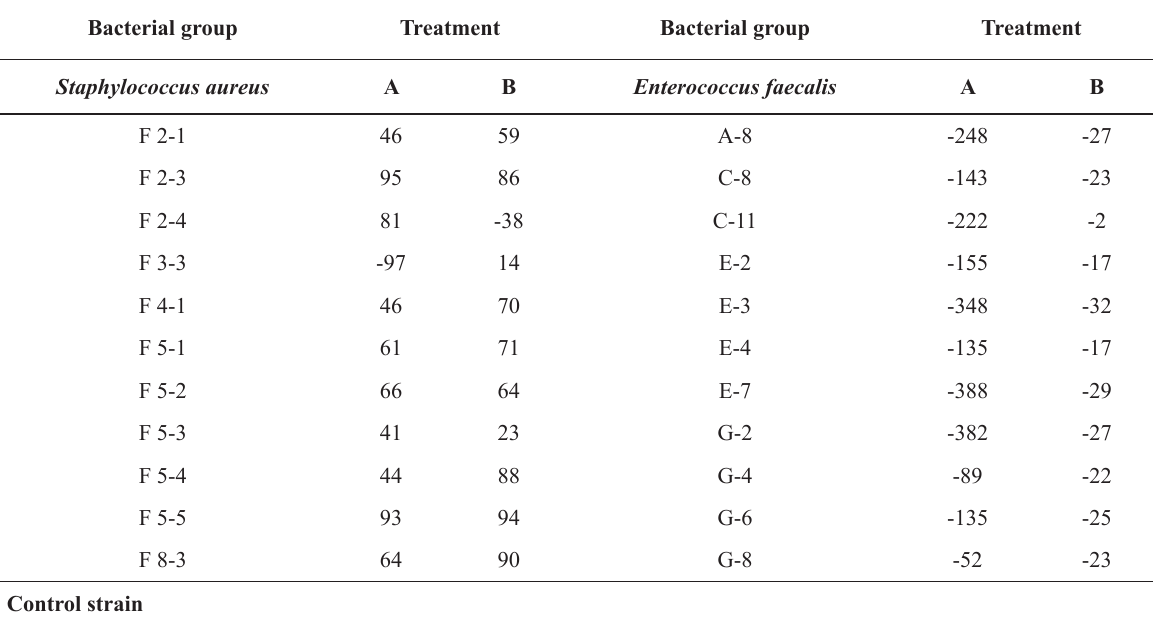
Effect of BLS P34 on metabolic activity of biofilm cells of Staphylococcus aureus and Enterococcus faecalis at 37ºC. Bacterial group